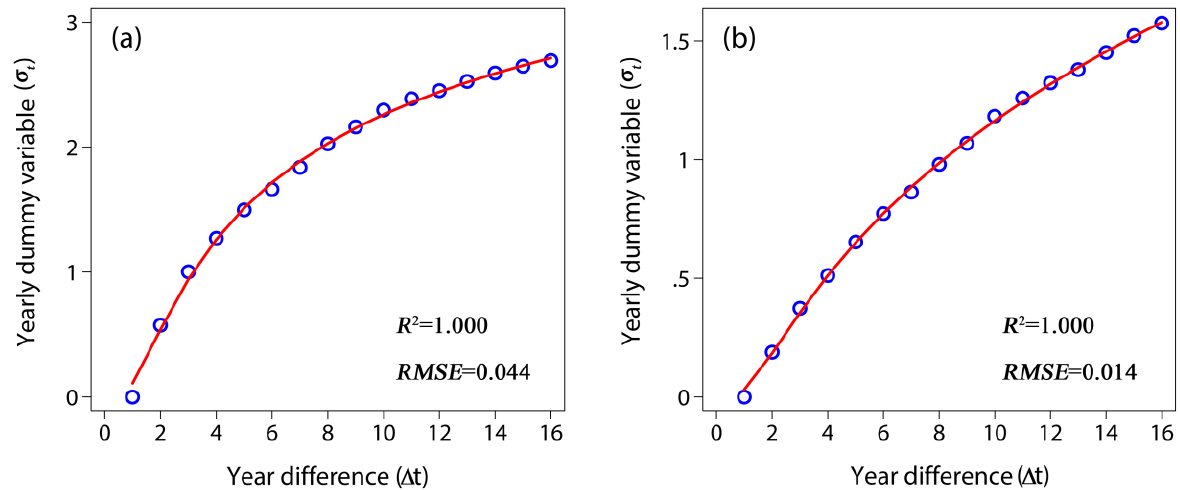
Figure 6. The time dummy variables σ are plotted against timeline ∆ t for ( a ) IUSSB and t ( b ) IUSSCE. Solid lines in red are regression lines of the vapor pressure fitting